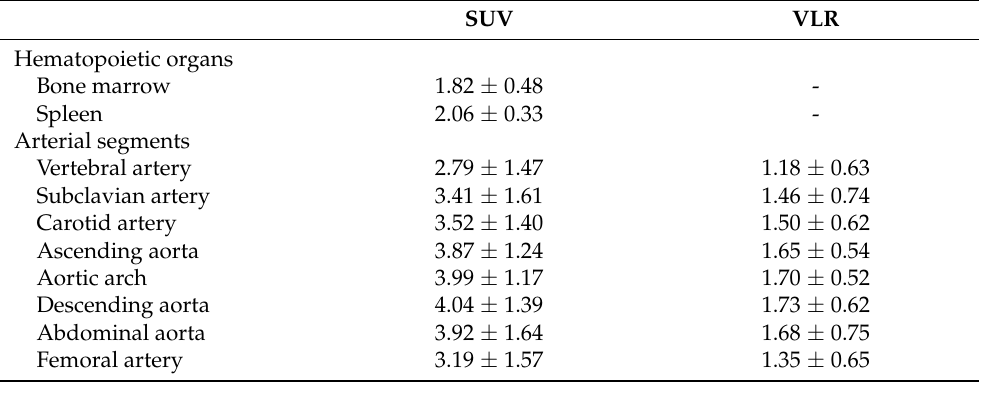
Table 2. Standardized uptake values of the bone marrow, spleen, and each investigated arterial segment (entire cohort). The vessel wall-to-liver ratios (VLRs) derived from all arterial segments. The means ± SD are given ( n = 94).